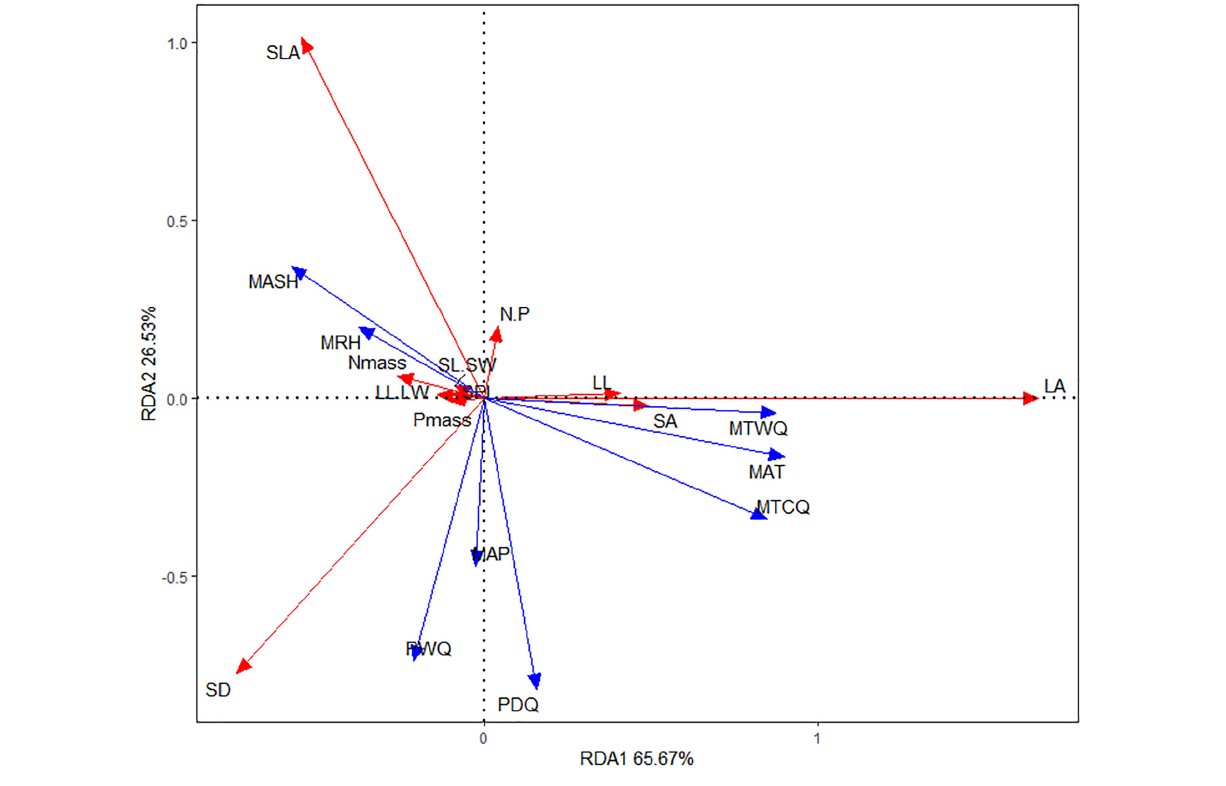
FIGURE 2 | Climate-related leaf trait dimensions from redundancy analysis (RDA). Red and blue arrows represent leaf traits and climatic factors, respectively. LL.LW, leaf length-width ratio; SL.SW, stomatal length-width ratio; Nmass, leaf nitrogen per mass; Pmass, leaf phosphorus per mass; N.P, leaf nitrogen-phosphorus ratio. Abbreviations of climate factors and part of leaf traits are as specified in Table 2